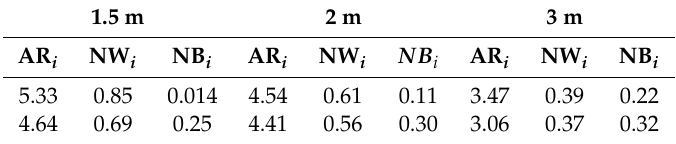
Table 1. Input parameters to the support vector machine (SVM) from images in Figure